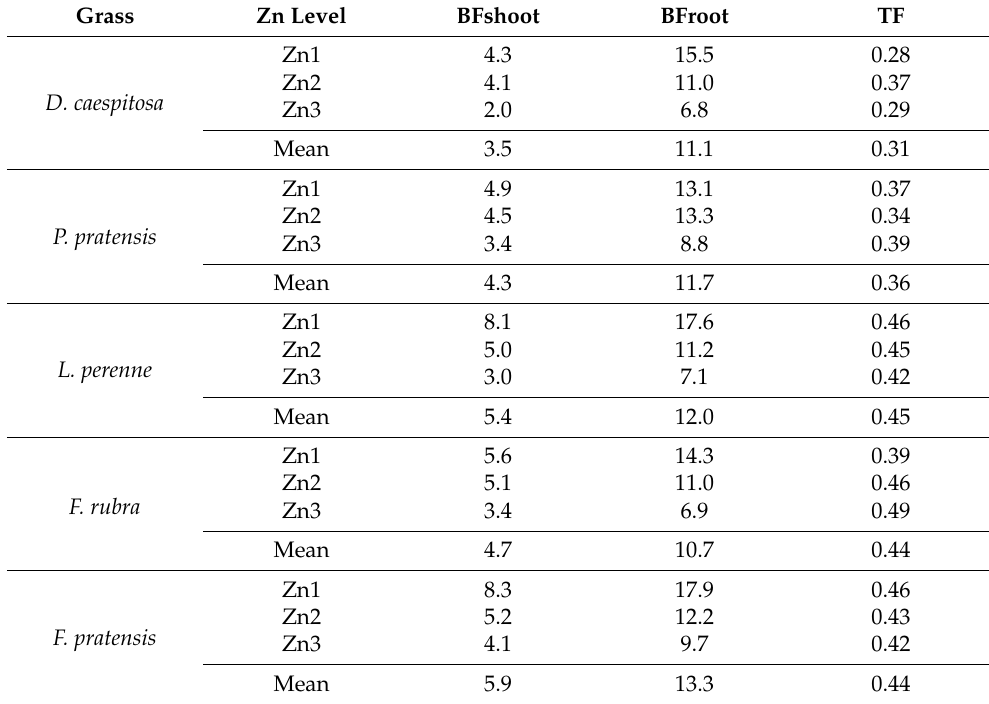
Table 4. Bioaccumulation (BF) and translocation factors (TF).